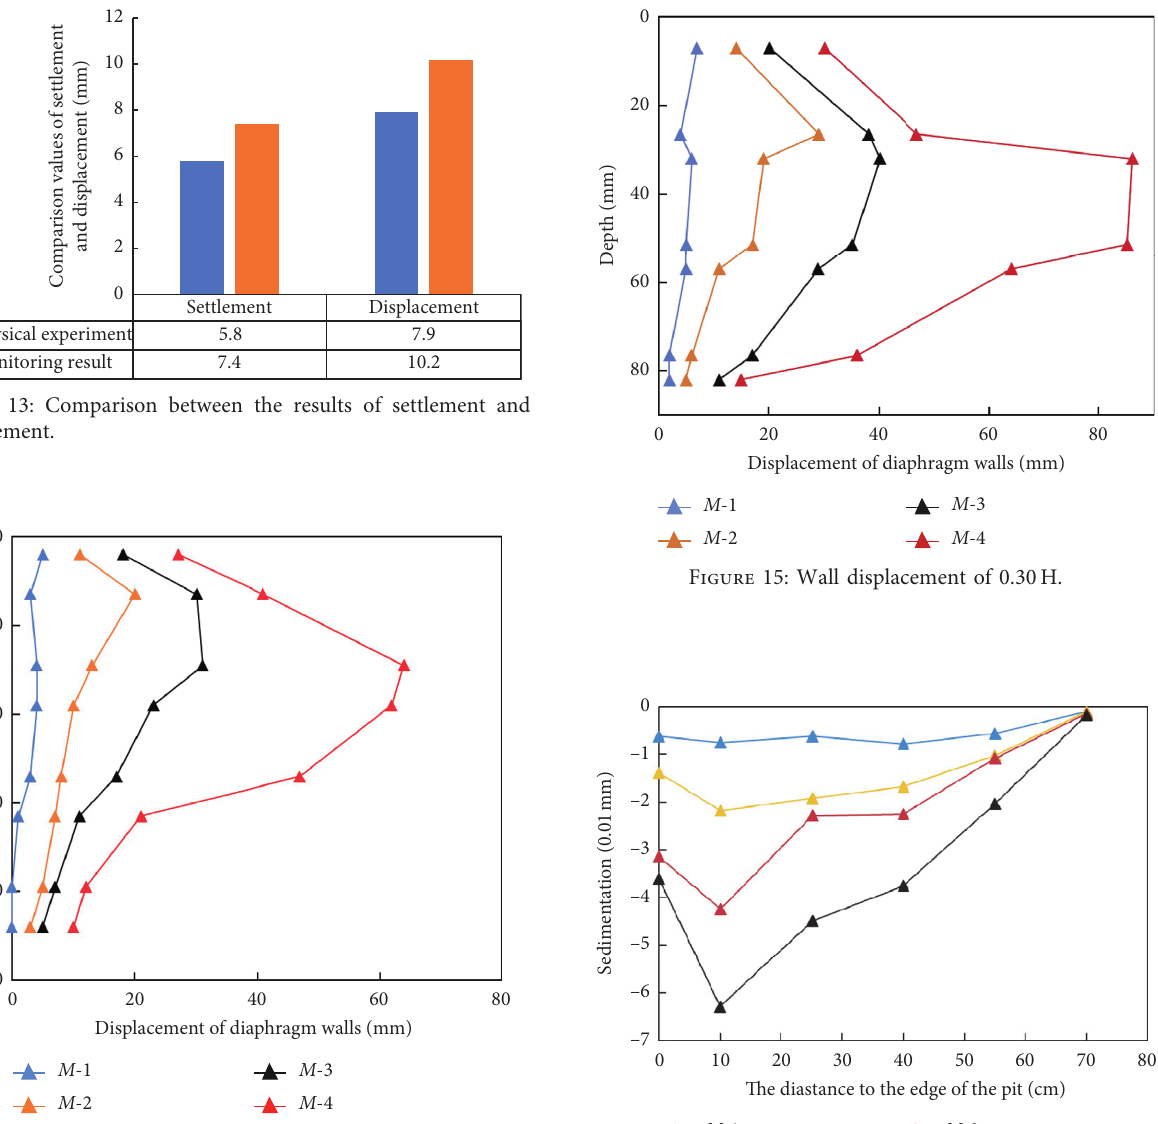
Figure 14: Wall displacement of 0.36H.